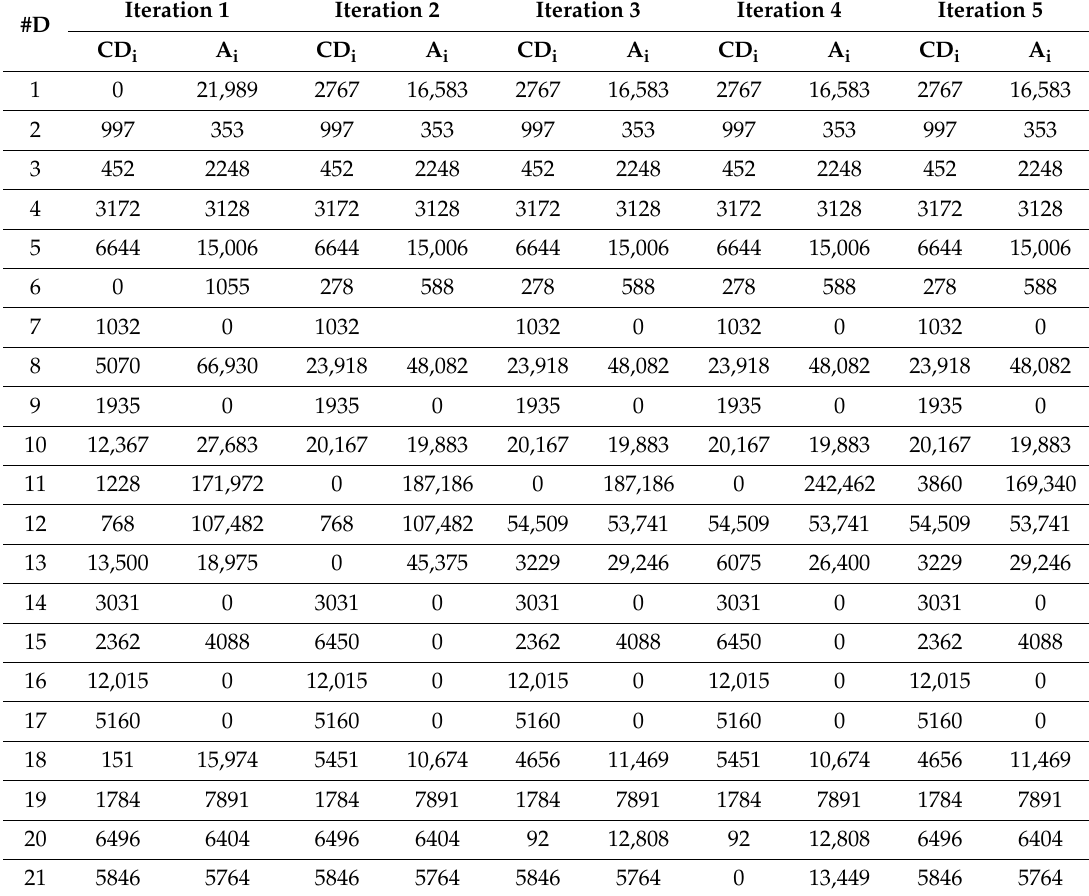
Table A2. Detailed results as CD i and A i of di ff erent